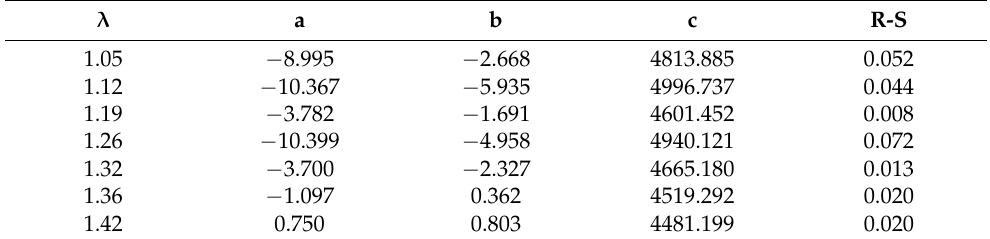
Table 5. Fitting of accumulated heat release and PMAX distribution under different λ .